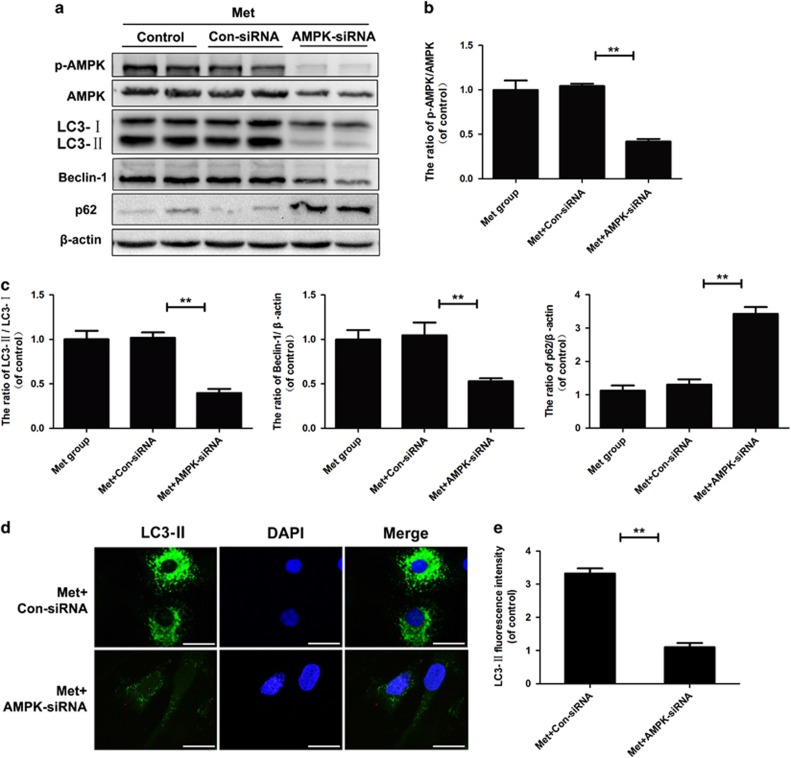
Inhibition of AMPK by siRNA significantly attenuates metformin-induced autophagy in nucleus pulposus cells. Cells were transfected with negative control siRNA (con-siRNA) or AMPK-siRNA before receiving metformin(100 μM). (a–c) The protein expression of p-AMPK, AMPK, LC3, Beclin-1 and p62 in the nucleus pulposus cells as treated above. (d, e)The representative LC3-positive autophagic vesicles were detected by immunofluorescence staining combined with DAPI staining for nuclei (scale bar: 25 μm). The data in the figures represent the averages±S.D. Significant differences between the treatment and control groups are indicated as **P<0.01, *P<0.05, n=3.